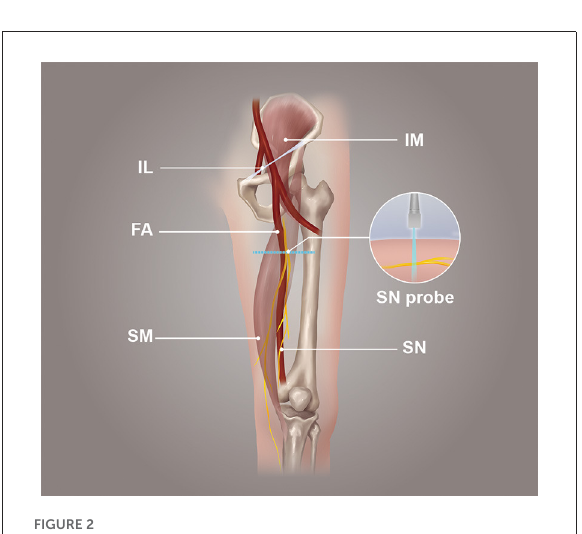
FIGURE2 The position of the probe in the transverse section of the saphenous nerve.